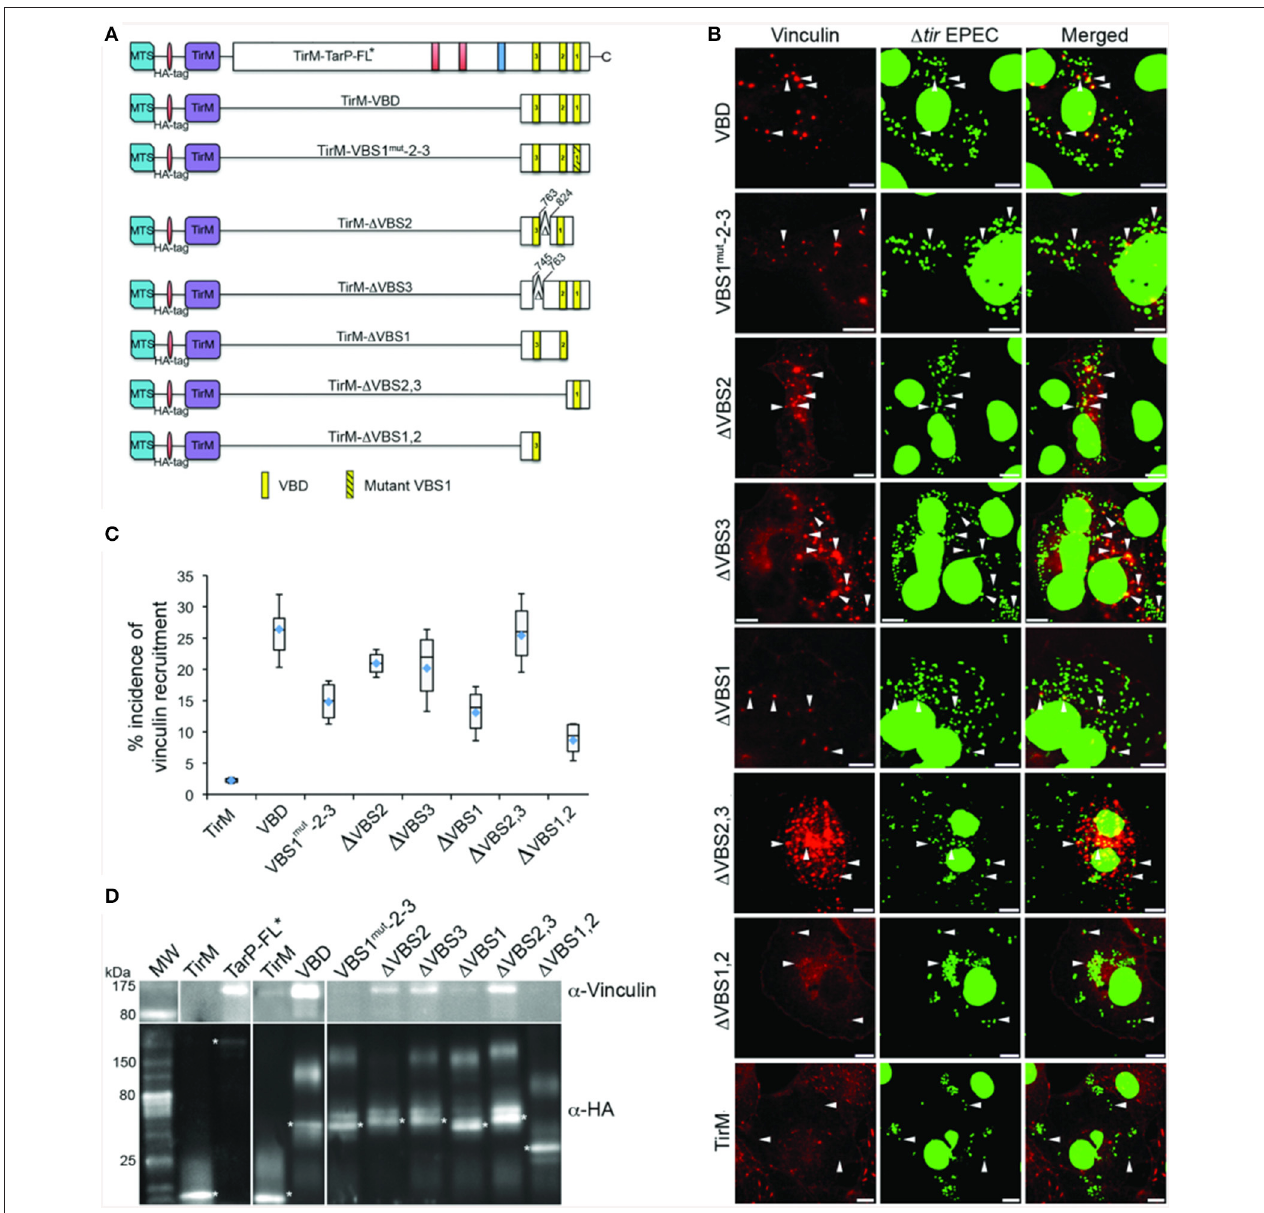
FIGURE 7 | Functional evaluation of the individual VBS motif revealed the importance of VBS1. (A) Schematic of Vinculin Binding Domain (TirM-VBD) derivatives designed for use with the EPEC-based assay. Indicated are the locations of the N-terminal membrane targeting sequence (MTS; cyan box), Ha-tag (red box), TirM (amino acids 260–395; purple box), proline rich domain (green box), actin binding domains (red box), the LD domains (blue box), Vinculin Binding Site 3 (VBS; brown box), VBS2 (orange box), and C-terminal VBS1 (yellow box). 1 indicates amino acids deleted in mutant TarP proteins, and the numbers indicate amino acid positions encoded within the C. caviae TarP gene. Yellow box with black stripes indicates a mutated VBS derivative. (B) Cos7 cells transfected with plasmids encoding the VBD (TirM-VBD), a VBD mutant derivative in which the critical leucines of VBS1 were converted to serines [TirM-VBS1(mut)-2-3], the VBD deleted for VBS1 (TirM- 1 VBS1), the VBD deleted for VBS2 (TirM- 1 VBS2), the VBD deleted for VBS3 (TirM- 1 VBS3), VBS1 or VBS3 were infected with 1 tir EPEC to induce clustering of the fusion protein. Transfected cells were identified by their ability to bind 1 tir EPEC. The white arrowheads indicate colocalization of Vinculin (red) with 1 tir EPEC (false-colored green). Vinculin was visualized with an anti-Vinculin antibody. Bacteria were visualized by DAPI staining. Scale bars: 10 µ m. (C) Adhered EPEC able to recruit Vinculin were enumerated for VBD, VBS1(mut)-2-3, 1 VBS1, 1 VBS2, 1 VBS3, VBS1, or VBS3, and data represented as box and whisker plot. Data compiled from three independent experiments. The graph shows range (statistical outliers excluded), first and third quartiles, and overall median (horizontal line). Diamonds indicate means. A range of 200–550 particles was counted. The asterisk and bars indicate significant difference between specific groups (One-way ANOVA, Tukey’s post-hoc test, P < 0.05 ). (D) The interaction of vinculin with the VBSs was evaluated by co-immunoprecipitation of HA-tagged VBD derivatives along with the full-length TarP and the negative control TirM at 32h post-transfection. The co-precipitated vinculin protein and the recombinant TarP and/or VBD constructs were visualized by western blot using antibodies to vinculin and the HA-tag, respectively. The HA-tagged proteins are indicated by asterisks. Note that the loss of VBS1 either through deletion or mutation consistently led to the loss of interaction with vinculin.